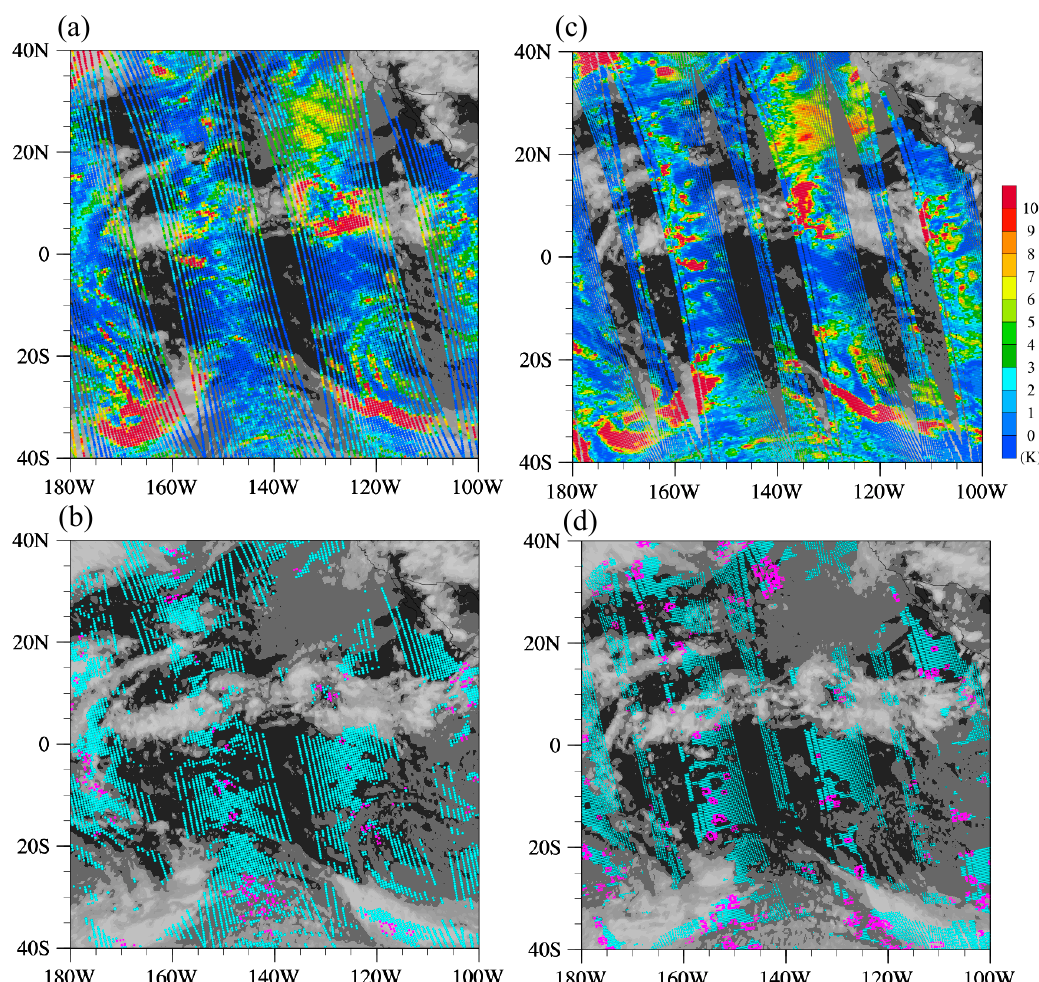
Figure 14. Spatial distributions of ( a ) AMSU-A channel-3 O-B- µ ( α )- µ ( ϕ ) and ( b ) data points satisfying ξ ≤ 2K within a 60-km radial distance (cyan) and additional clear-sky data points (magenta) found by the second step of the newly proposed scheme at ascending nodes on 15 July 2014. ( c , d ) are the same as (a,b) except for MWTS-2 overlapped with AMSU-A swaths.